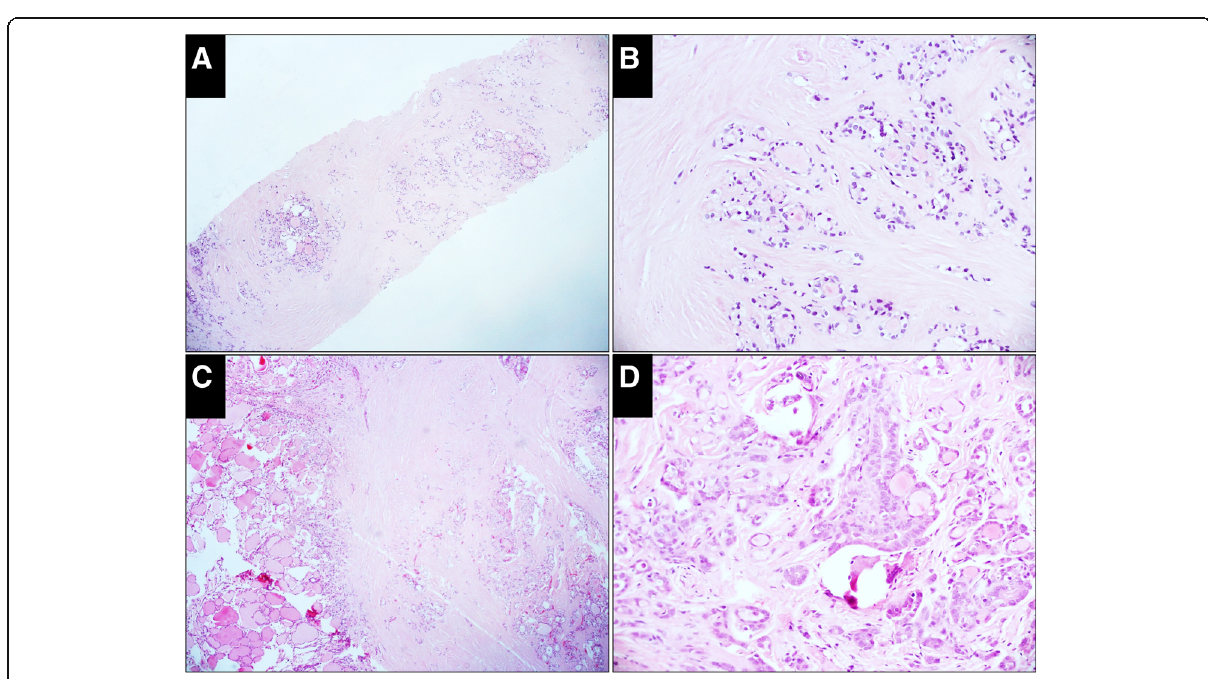
Fig. 3 Case classified as indeterminate in the CNB specimen but malignant in the resected specimen (H&E). a , The CNB specimen consists of hyalinized fibrous tissue with embedded microfollicles (× 50). b , High-power view of the microfollicle cells shows enlarged nuclei but neither glassy nor irregular membrane (× 200). c , A circumscribed sclerosing nodule is prominent in the resected specimen, in which microfollicles, small tubules and elongated glands are embedded (× 50). d, High-power view of the cells shows nuclei with features of papillary